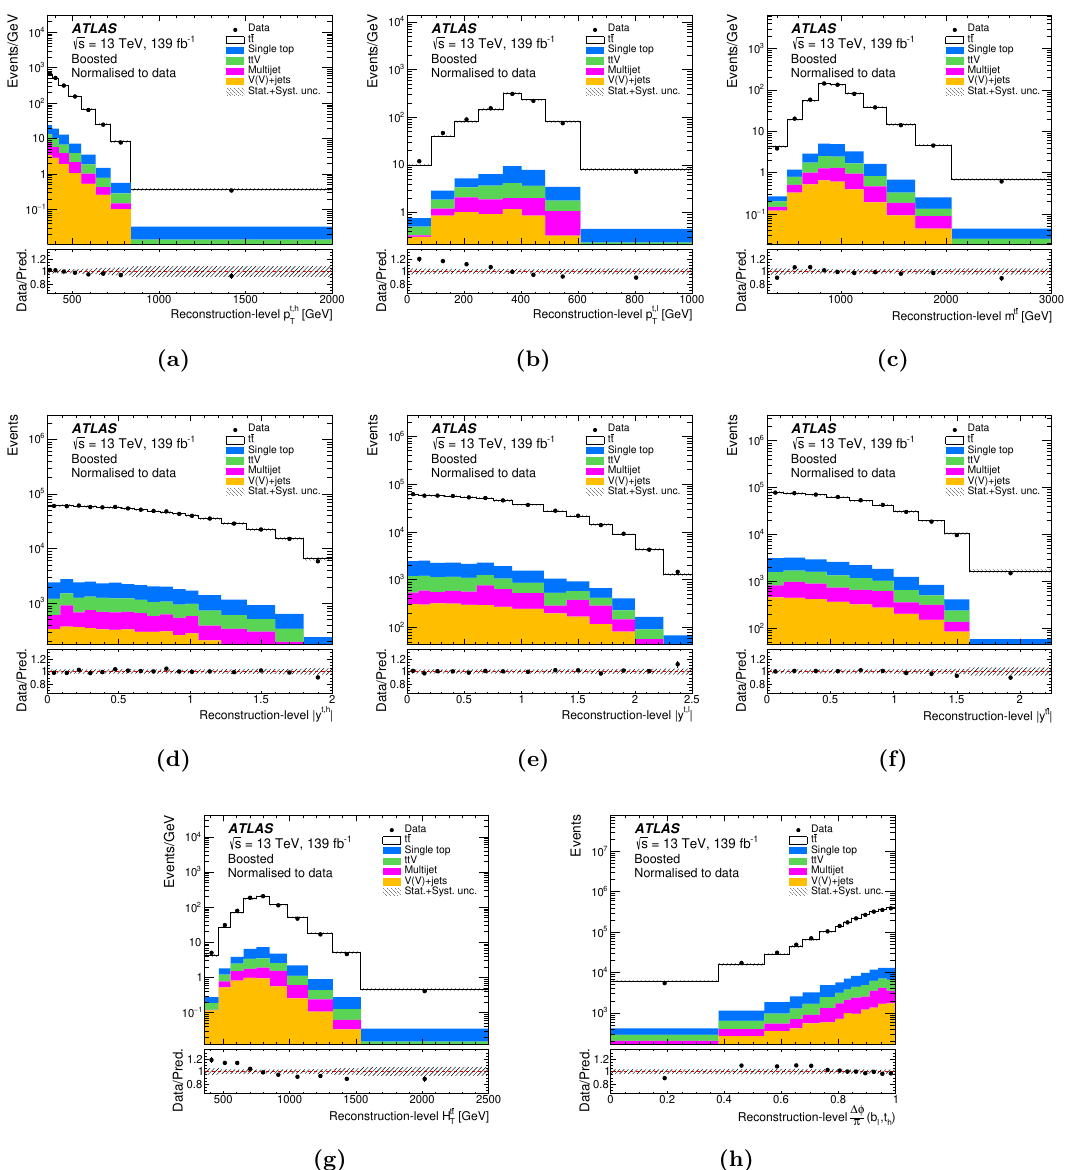
, (b) T and (h) ∆ φ ( b ) . The data are compared with the , t ‘ h T